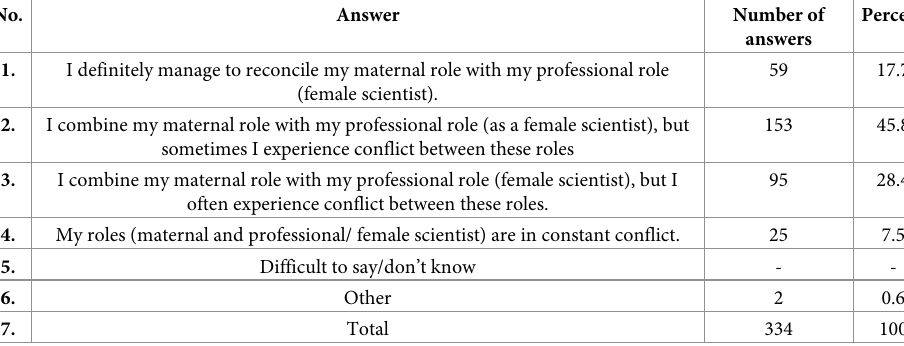
Table 8. Conflict between scientific career and motherhood as perceived by mothers-scientists. Source: Study by Ewa Krause. No.